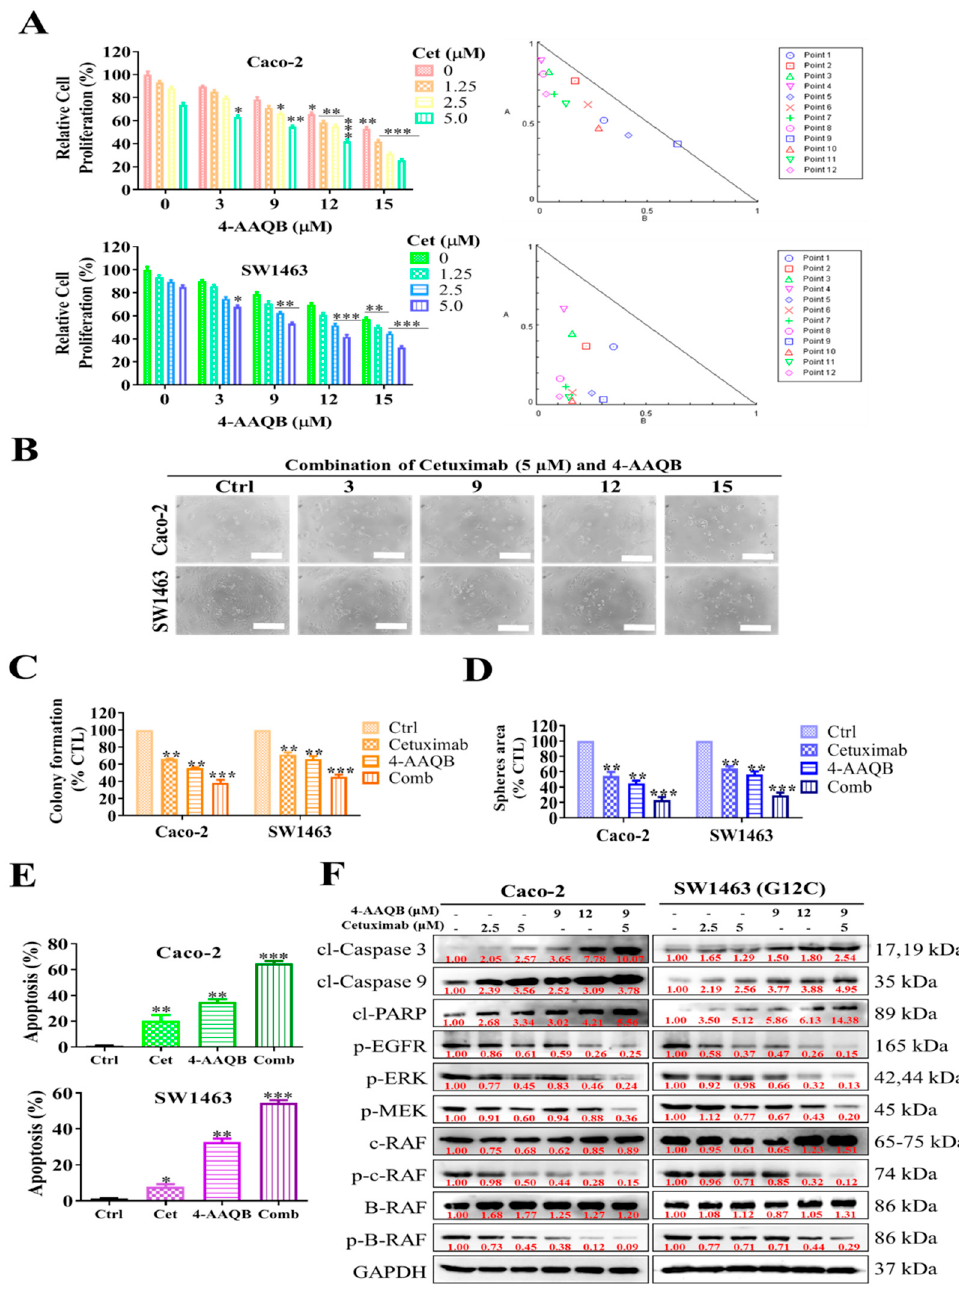
Figure 4. The effect of 4-AAQB and cetuximab combined treatment effect on KRAS wild-type and mutant CRC cell lines in vitro. ( A ) Isobologram analysis showing that the synergistic effects of 4-AAQB and cetuximab were achieved in different concentration combinations on both SW1463 and Caco-2 cell growth. The combination index (CI) using CompuSyn software [26] indicated the synergistic effect of the 4-AAQB-cetuximab combination therapy. (CI > 1.3: antagonism; CI = 1.1–1.3: moderate antagonism; CI = 0.9–1.1: additive effect; CI = 0.8–0.9: slight synergism; CI = 0.6–0.8: moderate synergism; CI = 0.4–0.6: synergism; and CI = 0.2–0.4: strong synergism). ( B ) Effects of 4-AAQB and cetuximab on SW1463 and Caco-2 cell morphology. The phase-contrast microscopy images represent the results from 1 of 3 independent experiments at 200 × magnification. ( C , D ) Significant reduction in the colony-forming, and tumorsphere generating abilities, and ( E ) induced apoptosis in SW1463 and Caco-2 cells were observed with the combination treatment. ( F ) Western blot analysis for cl-capase-3/9 and cl-PARP expression, together with the expression of p-EGFR, p-ERK, p-MEK, cRAF/BRAF and p-cRAF/BRAF after the 4-AAQB-cetuximab combination therapy, GAPDH was used as internal housekeeping control. * p < 0.05; ** p < 0.01; *** p < 0.001. Scale bar 100 µM.